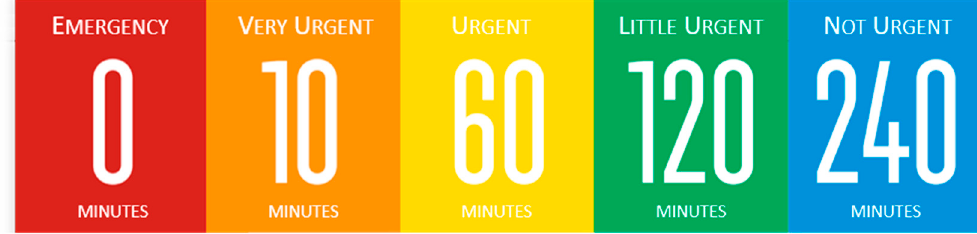
Figure 1. Manchester triage colors with the corresponding target waiting time.